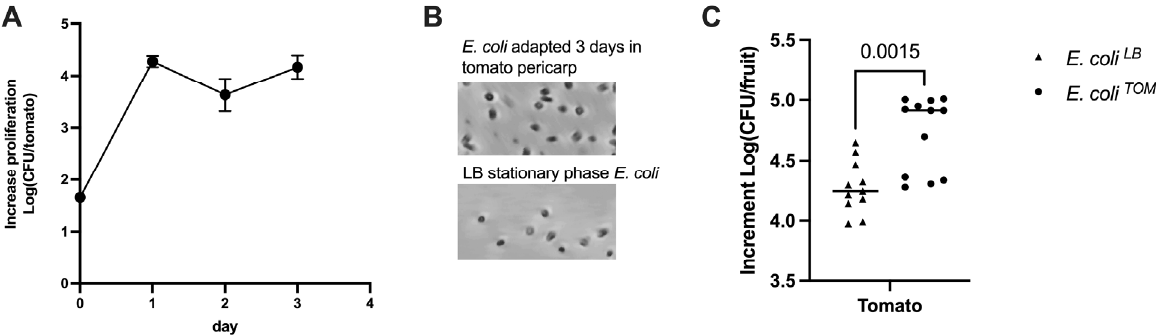
Figure 1. E. coli growth in tomatoes. ( A ) Increase in E. coli proliferation in tomato pericarp within 4 days. The decline of growth on day 2 is not significantly different in comparison to days 1 and 3 ( p < 0.1650). Signi fi cance occurs only in comparison with day 0. ( B ) Micrograph showing E. coli TOM and E. coli LB cells (magni fi cation of 400X). ( C ) Growth of pre-adapted E. coli TOM and E. coli LB in tomato pericarp. Error bars represent standard error. Horizontal bars in ( C ) show the signi fi cance of the T-test ( p < 0.05).